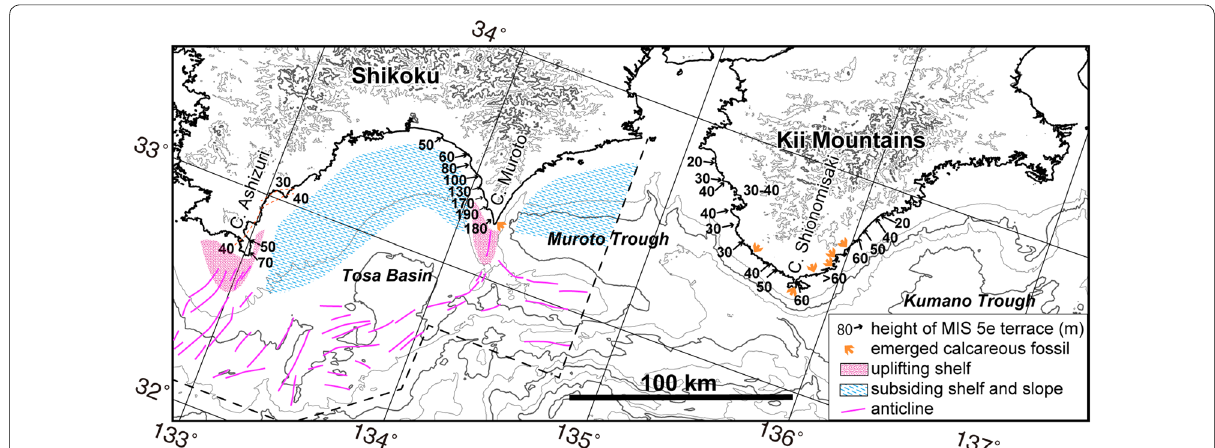
Fig. 2 Offshore geologic structure and marine terrace height in Shikoku and the Kii mountains. Offshore geologic structures south of Shikoku (within the dashed line) are simplified from Okamura (1990). Heights of the MIS 5e marine terrace are from Koike and Machida (2001). Locations of emergent fossil assemblages are from Maemoku (2001) and Shishikura et al.